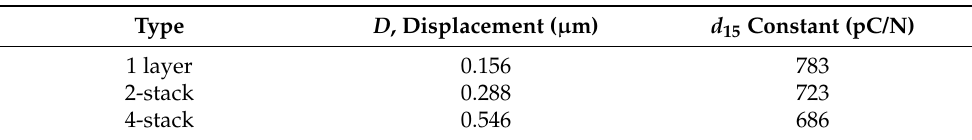
Table 1. Displacement D and d 15 constant values of length shear-mode stack actuators at 199 V (3.98 kV/cm) applied voltage.